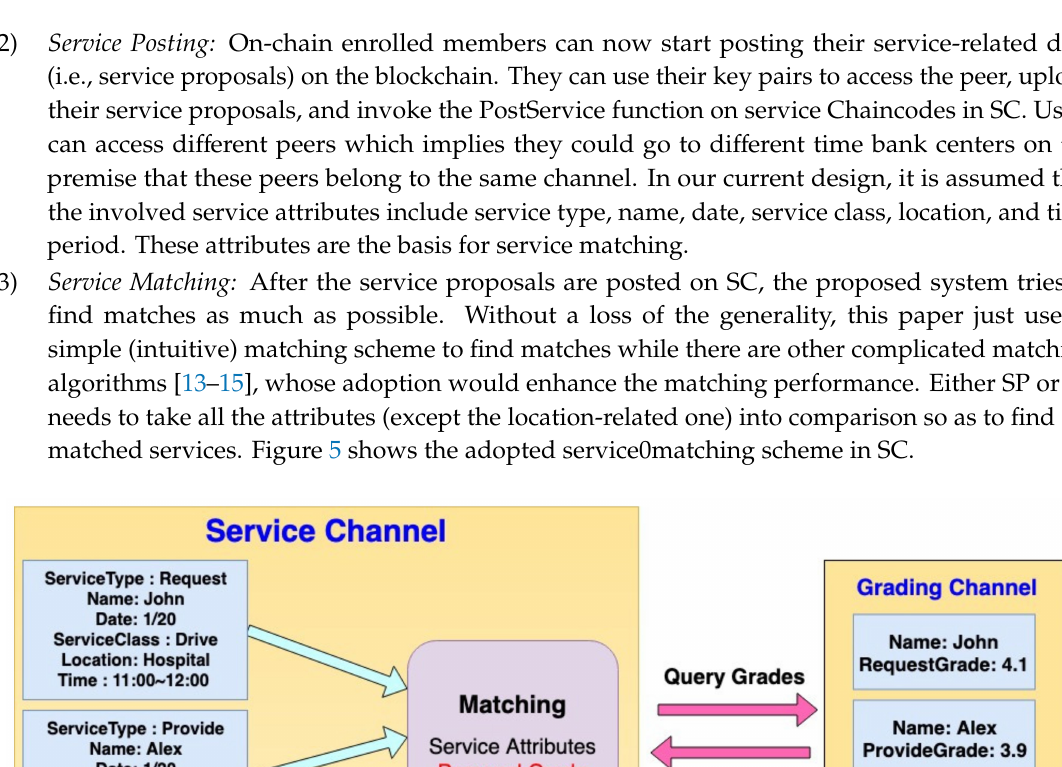
Figure 4. The information flow and the processes in the token channel (TC).